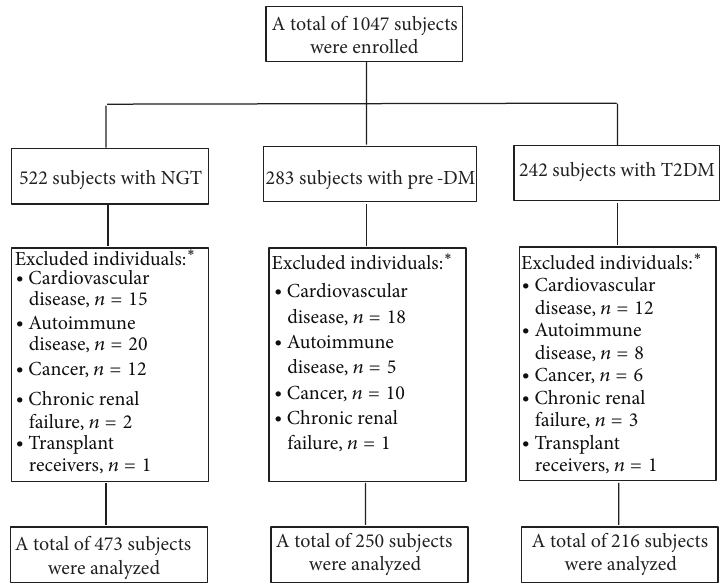
Figure 1: Enrollment. ∗ Some individuals had two or more